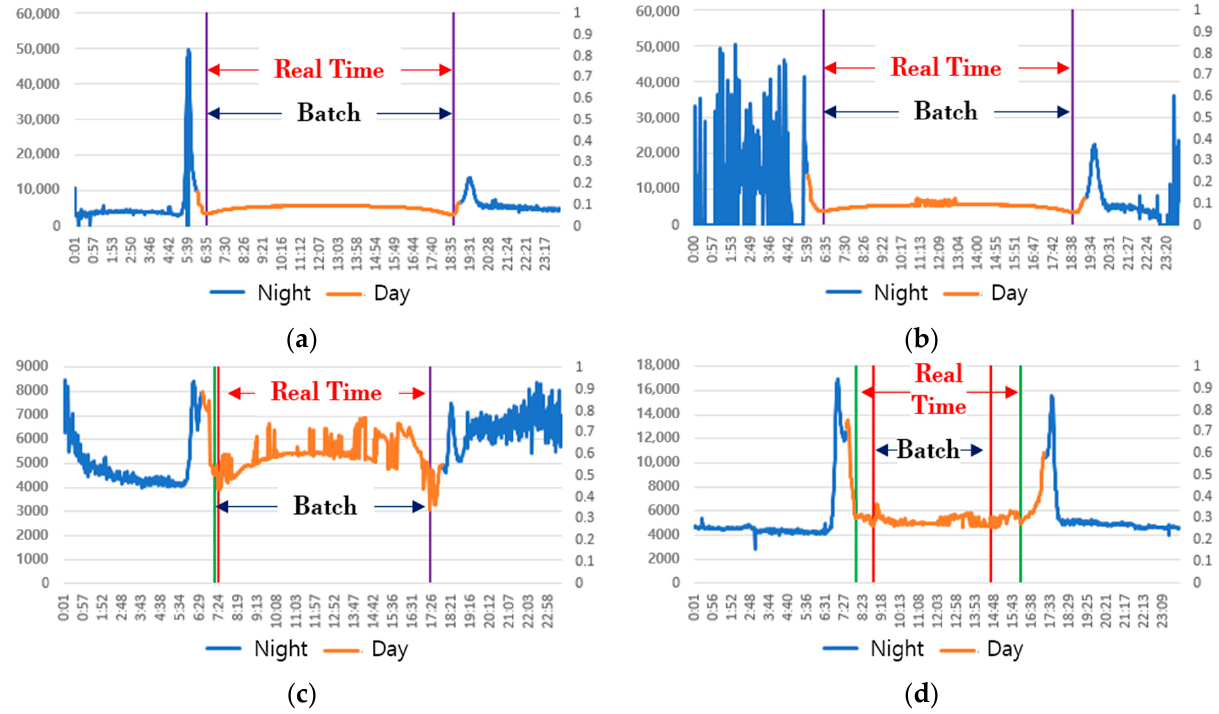
Figure 6. Search results of the lowest color temperature point and the color temperature cycle zone . ( a ) Irregular color temperature inclusion ratio of 0% (8 April 2020); ( b ) Irregular color temperature inclusion ratio of 10% (27 April 2020); ( c ) Irregular color temperature inclusion ratio of 30% (15 October 2019); ( d ) Irregular color temperature inclusion ratio of 50% (11 December 2020).